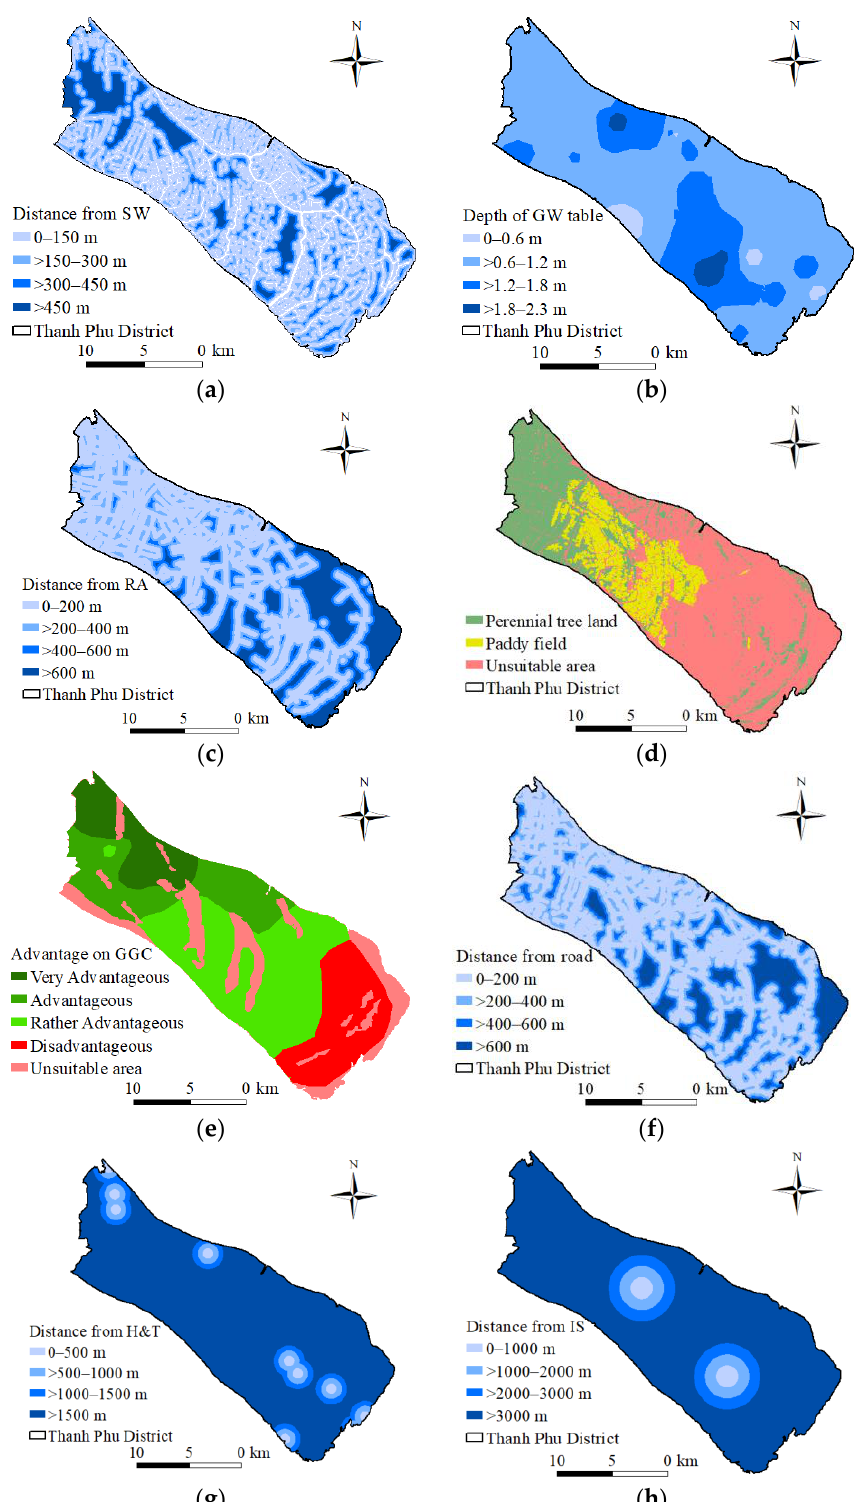
Figure 4. Considered criteria in the model: distance categories from surface water ( a ); distribution of ground water level ( b ); distance categories from residential areas ( c ); suitable land use types ( d ); advantages for geo-environmental and geotechnical characteristics ( e ); distance categories from main roads ( f ); distance categories from historical and tourism sites ( g ); distance categories from industrial sites ( h ).